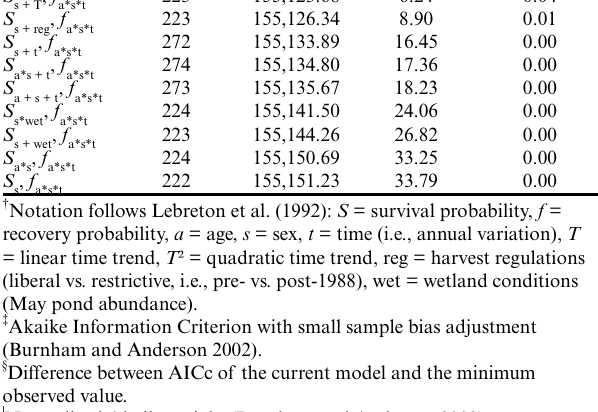
Fig. 6. Annual survival rates ( S ) for Northern Pintail ( Anas acuta ) banded in Alberta and Saskatchewan, Canada (≤ 54° N latitude) from 1960–2014. Lines (upper dashed line is for males) are predicted values of S from the most parsimonious model, S , f , whereas point estimates are from the corresponding + T² a*s*t general model with full time-dependency in survival S Point estimates for the interval 1960–1961 were not estimable and are not